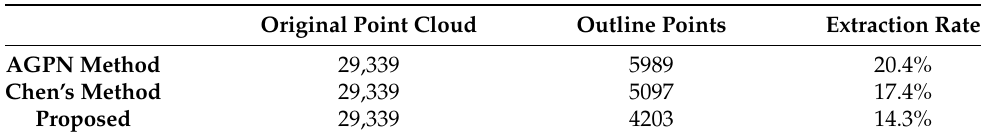
Figure 17. Comparing the results on the "3S” structure of Wuhan University: ( a ) original point cloud, ( b ) extracted feature points using AGPN [16], ( c ) extracted feature points using Chen’s method [17] ( d ) extracted feature points using the proposed methods. the ( e ) extracted feature and planar points. Green indicates the planar points, and red represents both the boundary and the fold edge points. Table 9. Comparison of the extracted feature (fold and boundary) points using the three methods for “Computer World” building.